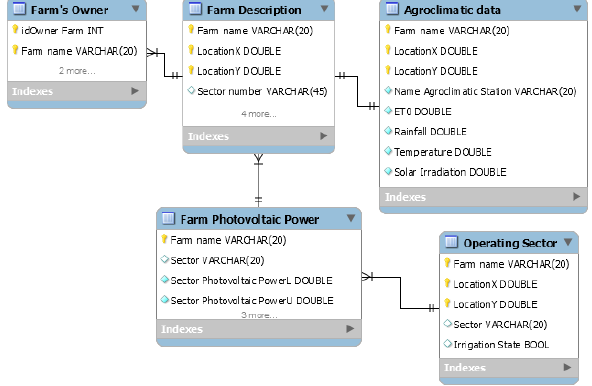
Figure 2. Architecture of the open database of RESSIM.